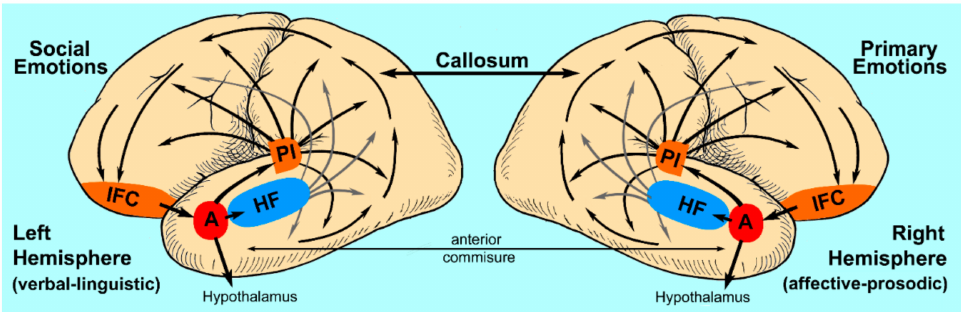
Figure 1. A highly schematized drawing depicting the emotional and mnestic pathways and neural networks that are involved with emotions, memory, executive functions and cognitive appraisal that ultimately furnish feedback to the amygdala and hippocampal formation (A = amygdala; HF = hippocampal formation; IFC = infero-frontal cortex; PI = posterior insula). Not shown are the ipsilateral parallel convergent inputs from the primary visual, somatosensory and auditory cortices that convey exteroceptive information to the amygdala and hippocampal formation for generating an emotional experience and laying down memories that store both the factual and emotional aspect of the exteroceptive event [1,17,18,20,74]. The nodal point for processing exteroceptive information into memory is the hippocampal formation, however the mnestic information is actually stored in neocortex in a distributed neural network (multiple gray arrows). The nodal point for generating an emotional reaction to exteroceptive information is the amygdala but to experience and remember the emotional event requires the participation of the posterior insula and its associated neural